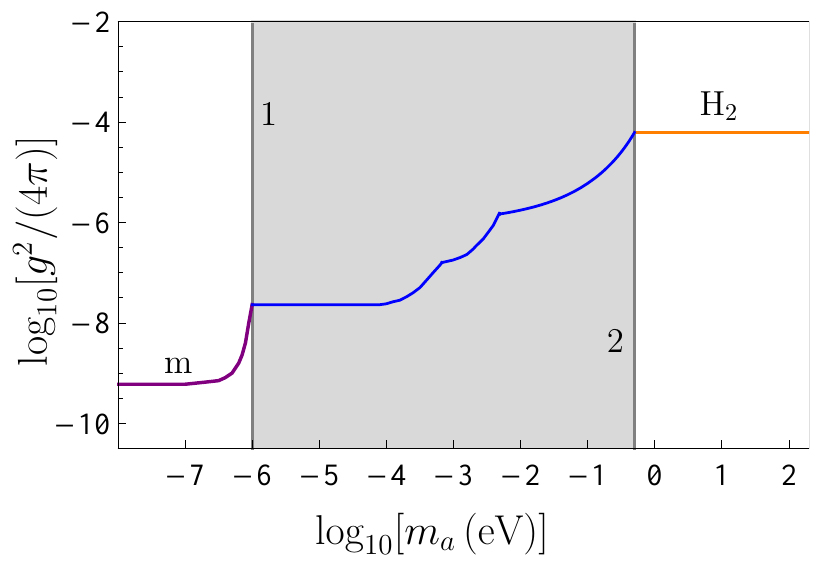
Figure 4. The strongest laboratory constraints on the coupling constant of axions and axionlike particles to nucleons obtained from the magnetometer measurements (line labeled “m”) and from the experiment with a beam of molecular hydrogen (line labeled “H 2 ”). The vertical lines labeled 1 and 2 indicate the current borders for the strongest constraints obtained from the gravitational experiments and Casimir physics which are shown by the envelope curve in between lines 1 and 2. The plane areas above the lines are excluded and below them are allowed by the measurement data.